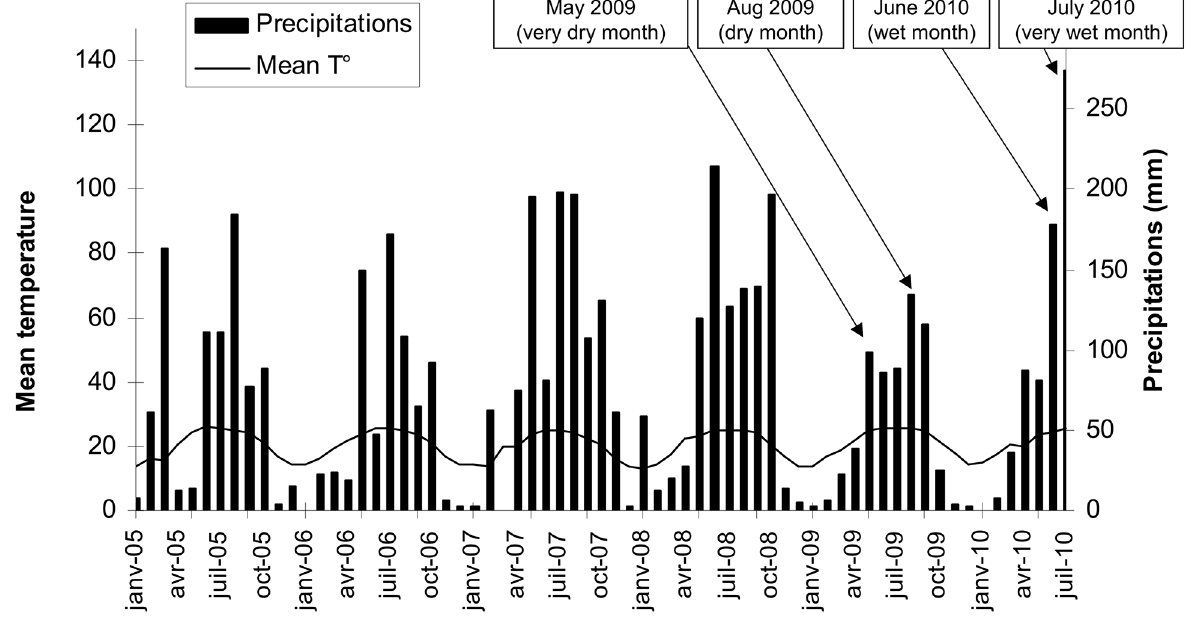
Figure 1. Mean temperature and precipitations in Liuku. Diagram from Liuku meteorological station situated 30 km south from the field site (source: Meteorological Bureau of Yunnan Province). Data from January 2005 to May 2010. Arrows show the months when roots were collected.